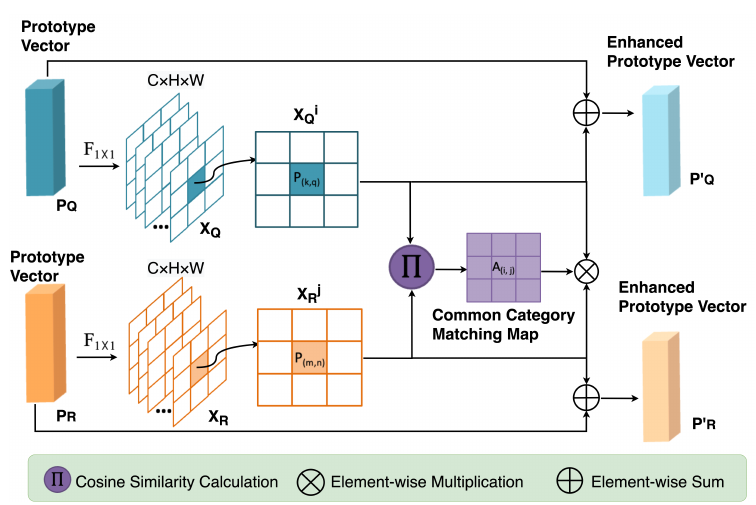
Figure 3. The schematic diagram of the PIE